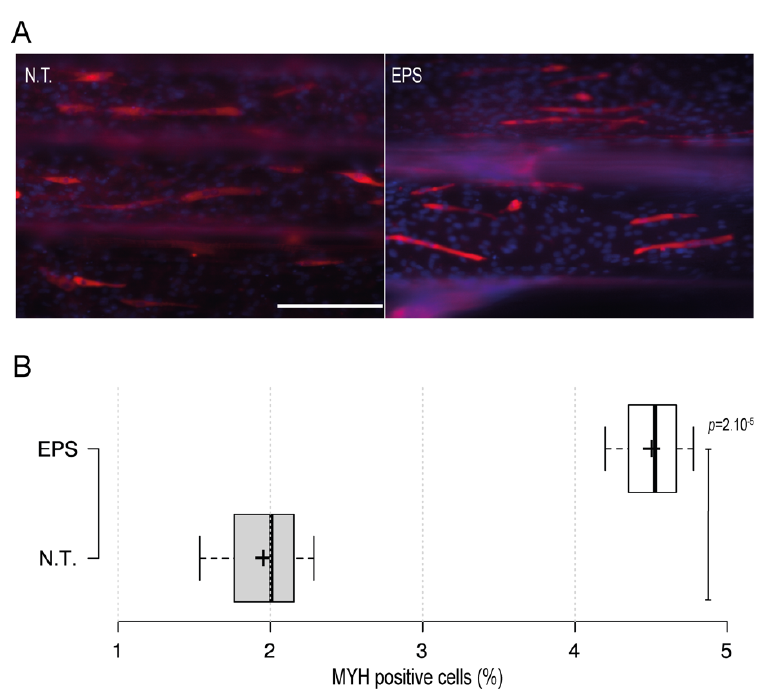
Figure 3. The impact of the electrical pulse stimuli (EPS) on myotubes differentiation. On day four after the initiation of the differentiation, cells were exposed to EPS for 3 h, cultured for 24 h, and then immunofluorescence staining of the myogenic MYH was conducted. ( A ) Fluorescence microscopy images of MYH expression in cells under no treatment conditions (N.T.) and EPS conditions. Red: MHY, Blue: DAPI; Scale bar of 200 µm. ( B ) Box plot showing MYH positive cells populations in 3D-PMMD under N.T and EPS conditions; box limits indicate the 25th and 75th; ( n = 4). p values were obtained by unpaired t test.